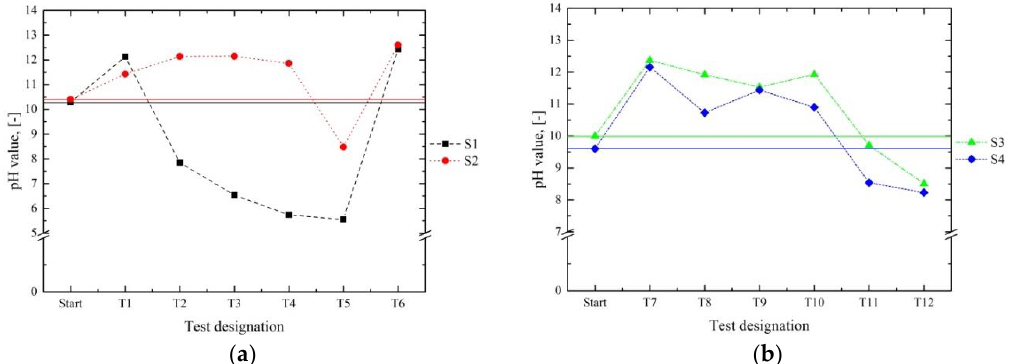
Figure 5. pH value before (start, continuous line) and after the tests (T1 – T6) of series 1 ( a ), as well as the tests (T7 – T12) of series 2 ( b ) [3].